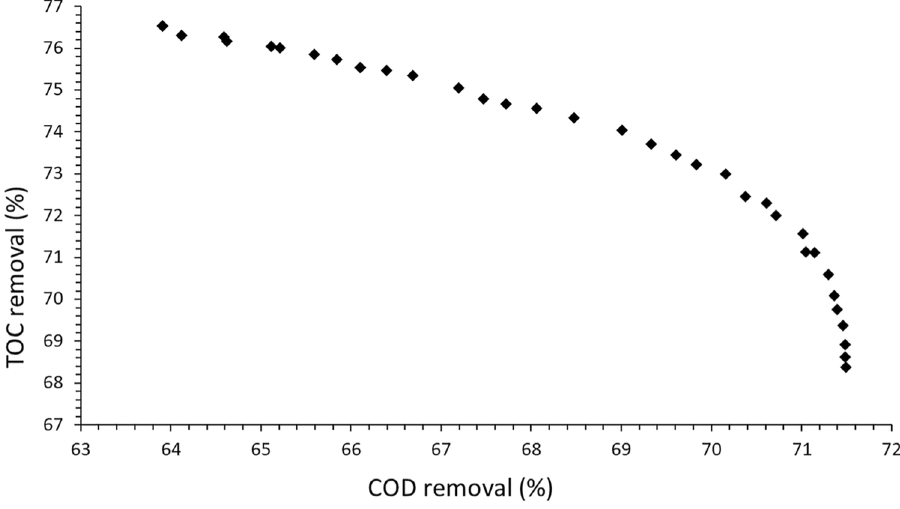
Fig. 5 Pareto-optimal set of solutions computed for multi- objective optimization of TOC removal efficiency (Objective-1) and COD removal efficiency